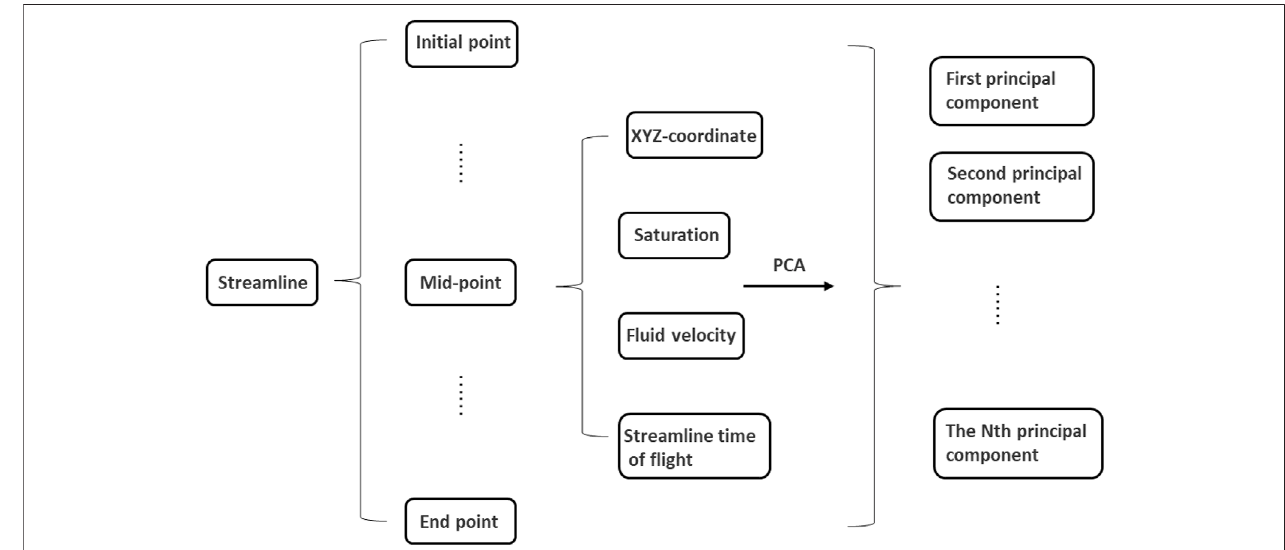
FIGURE 1 | Streamline attribute dimension